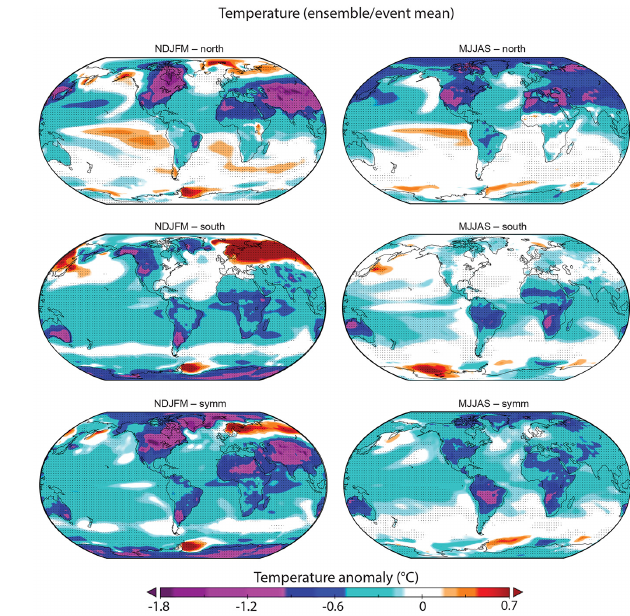
Figure 2. CESM spatial composite of surface temperature anomaly ( ◦ C) for (top row) ASYMM NH , (middle row) ASYMM SH , and (bottom row) SYMM events, each in (left column) NDJFM and (right column) MJJAS. Stippling indicates statistical significance using a two-sided Student’s t test ( p